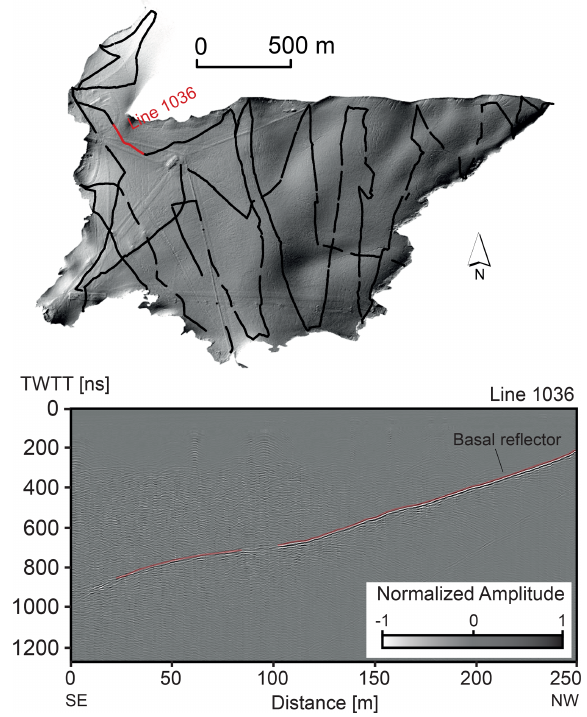
Figure 2. Acquisition lines from August 2018. The cumulative length is about 18km. Hill shade from the DEM derived from drone images. The straight lines visible on the hill shade are ski lifts and transit tracks for snow groomers. A GPR line is displayed, with the basal reflector